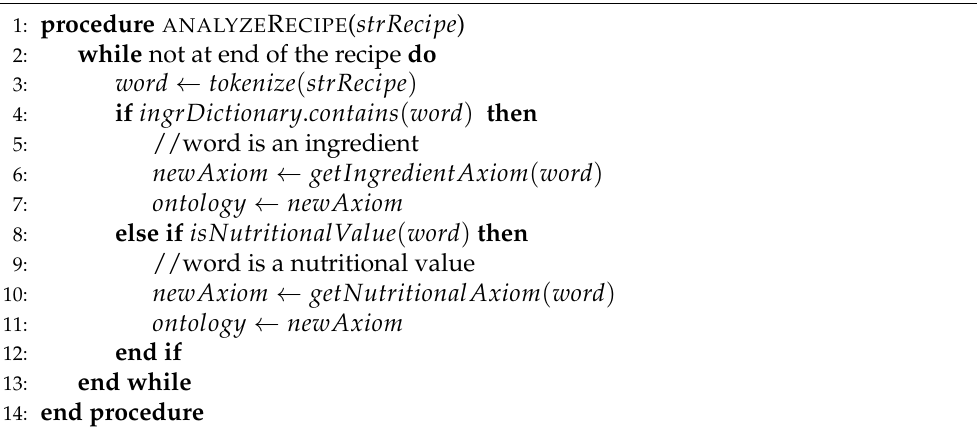
Algorithm 1 Mapping ingredients.